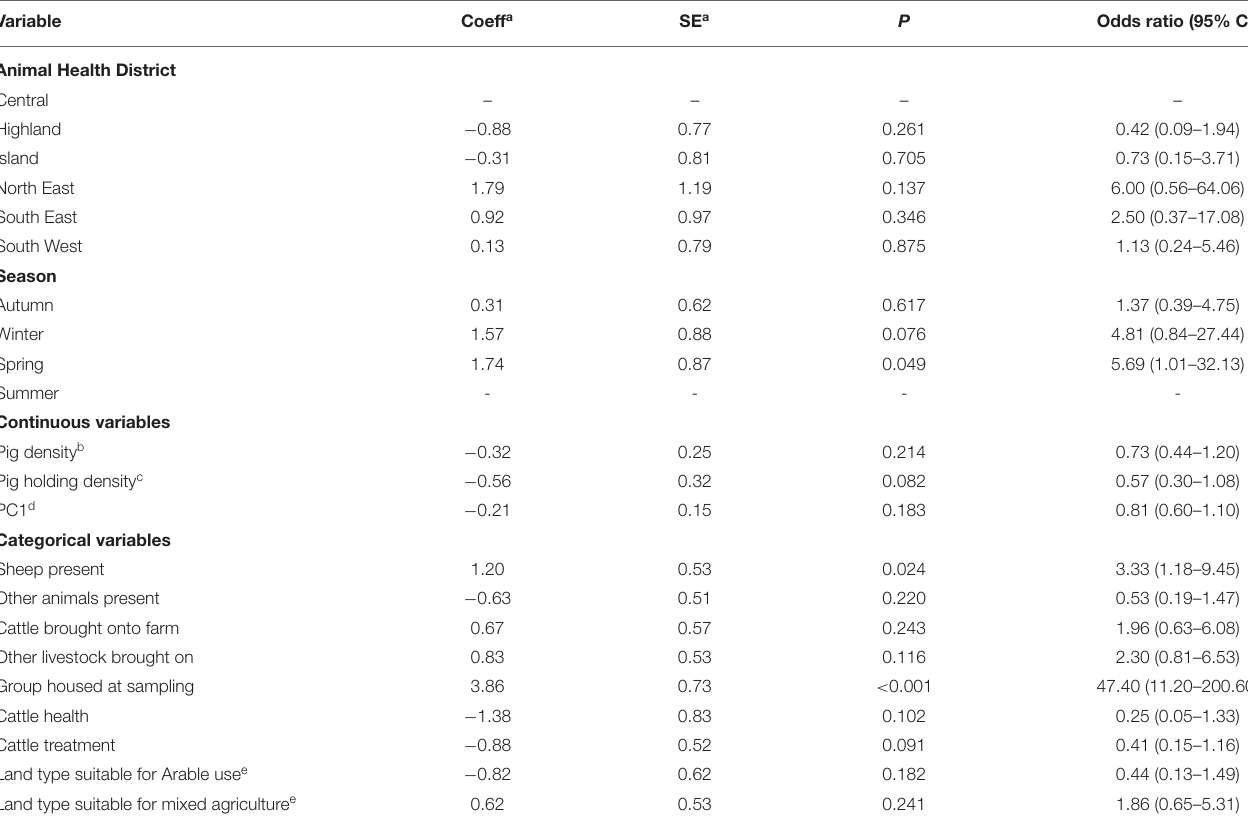
TABLE 2 | Region, season and herd management variable association with herd intI2 PCR status, by a univariable generalized linear mixed model, given as odds ratio with corresponding 95% confidence intervals (CI), for variables where P < 0.25. Variable Coeff a SE